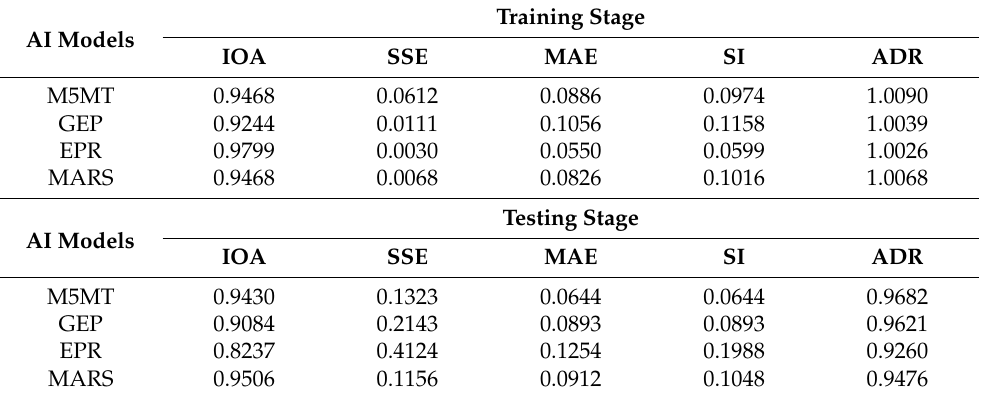
Table 2. Statistical performances of the AI models in the estimation of V ∗